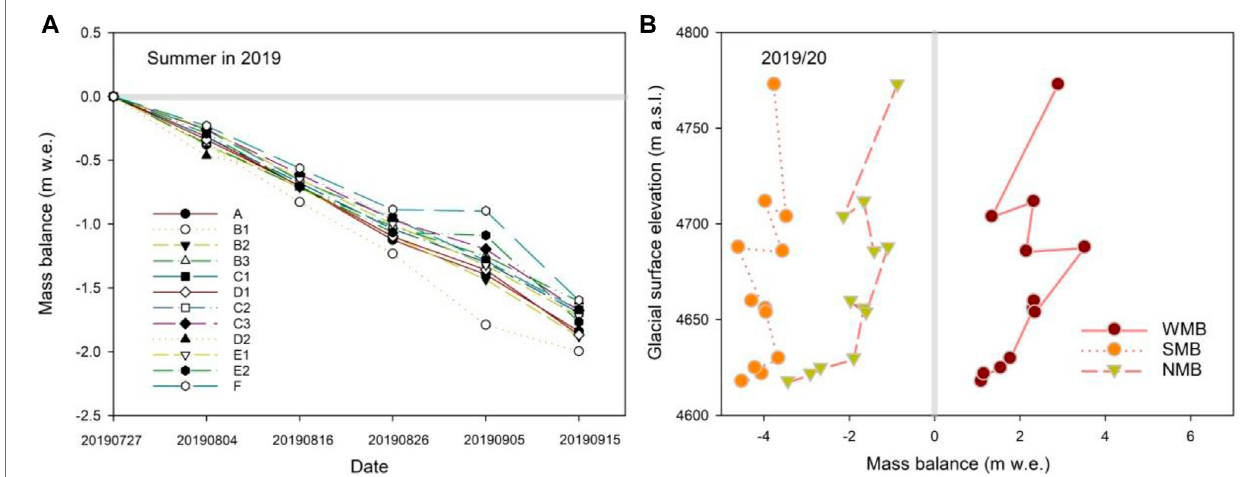
FIGURE 4 | Mass balance at observation points on the Baishui River Glacier No. 1 from 2019 to 2020: (A) summer of 2019; and (B) 2019 to 2020.